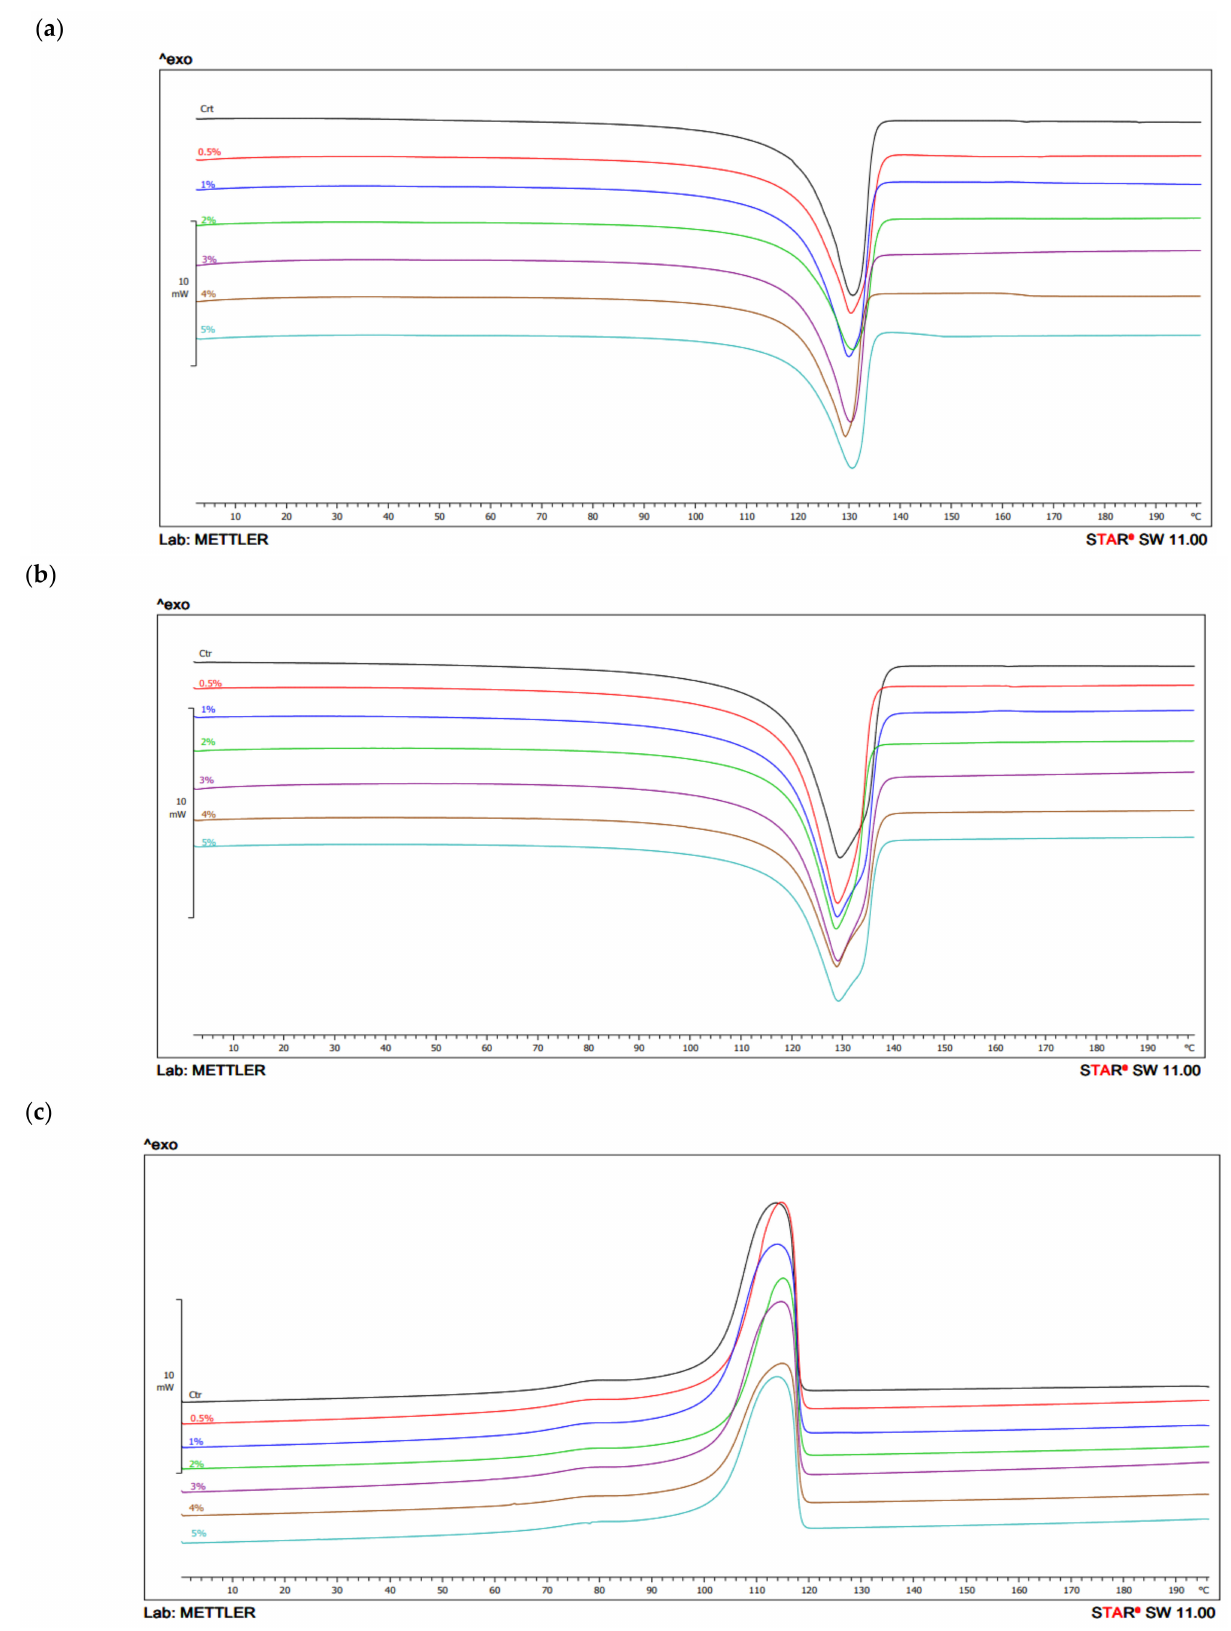
Figure 6. DSC thermogram: ( a ) first heating; ( b ) second heating; ( c )